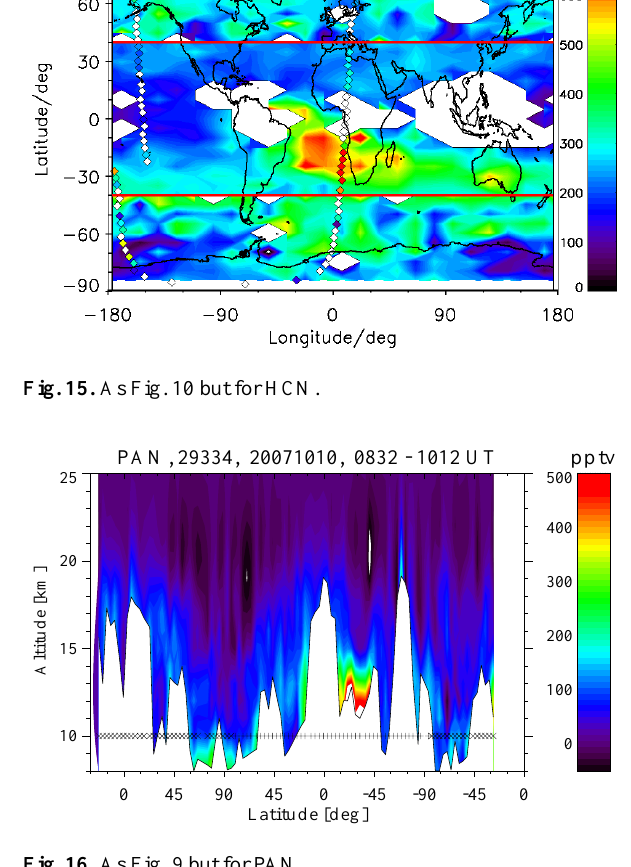
Fig. 16. As Fig. 9 but for